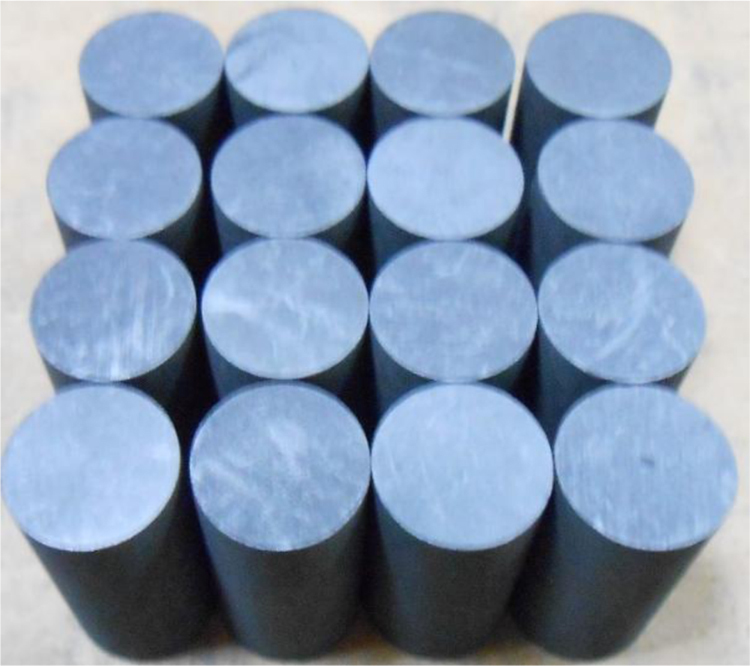
The picture of compression samples (NG-CT-10, Φ10.0 × 20.0 mm).